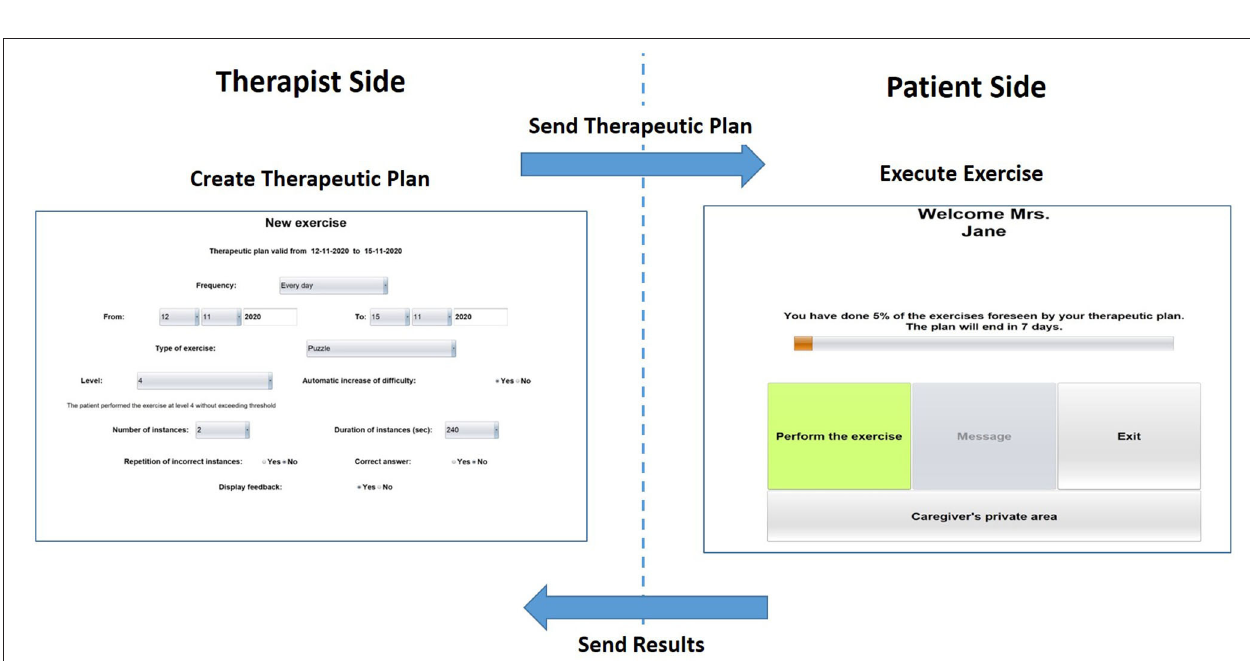
FIGURE 2 | Home page of the therapist-side of the interface for setting the requirements for the exercise plan (left) and home page of the patient/caregiver-side of the interface (right) . inpatients with Parkinson Disease-Mild Cognitive Impairment (68, 69) and also in older adults with other forms of early cognitive impairment (70). Following these encouraging results